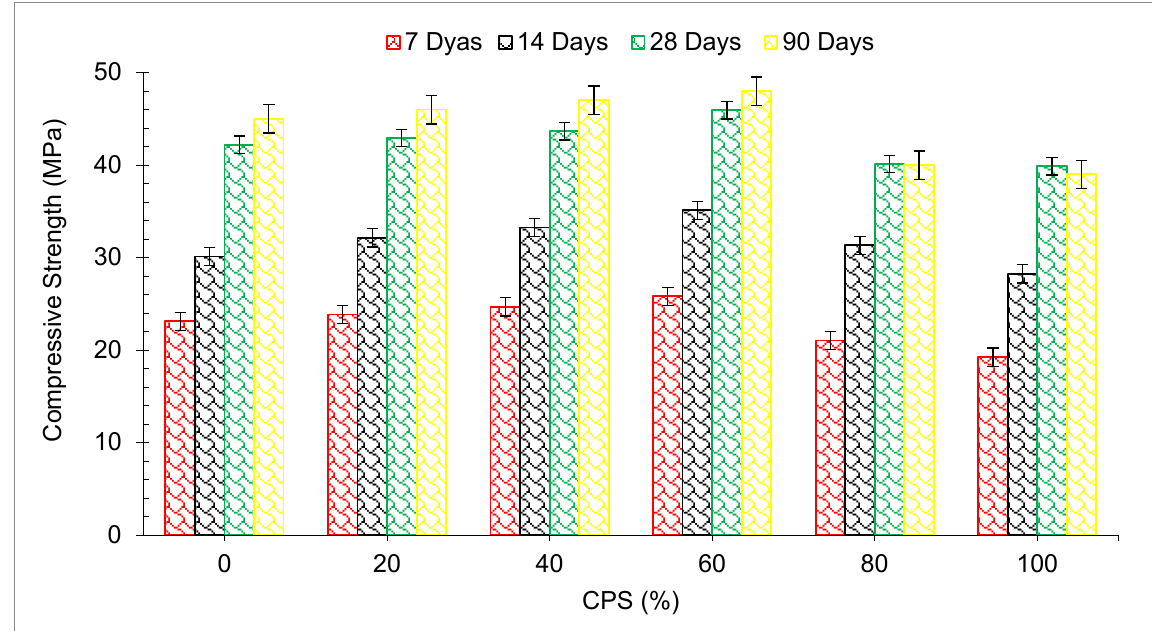
Figure 7. Compressive strength of concrete [45].